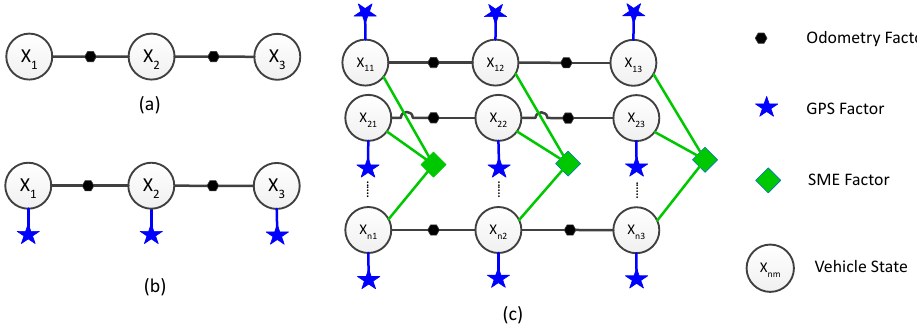
Figure 2. ( a ) Factor graph for a single vehicle with 3 state nodes and 2 odometry factors; ( b ) Factor graph for a single vehicle with 3 state nodes, 2 odometry factors and 3 GPS factors; ( c ) Factor graph for n vehicles with 3 state nodes each, 6 odometry factors, 9 GPS factors and 3 symmetric measurement equation (SME)